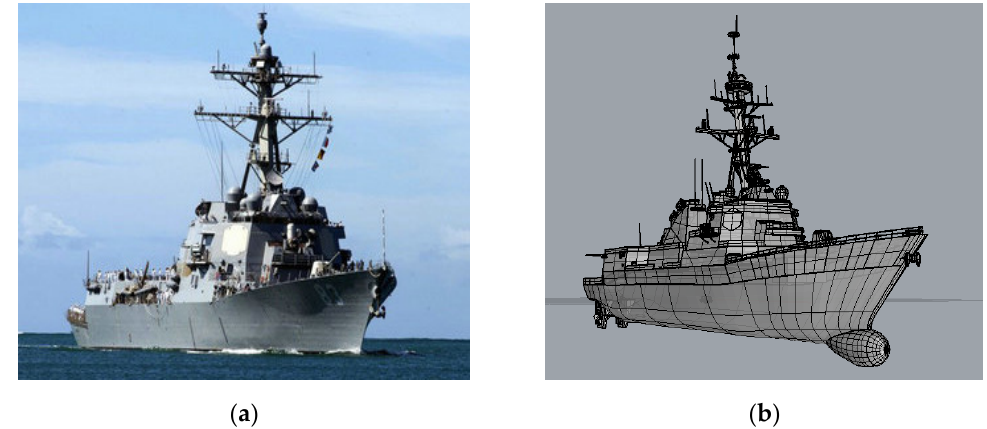
Figure 13. Destroyer model. ( a ) Photograph of the destroyer. ( b ) 3-D CAD model of the destroyer.